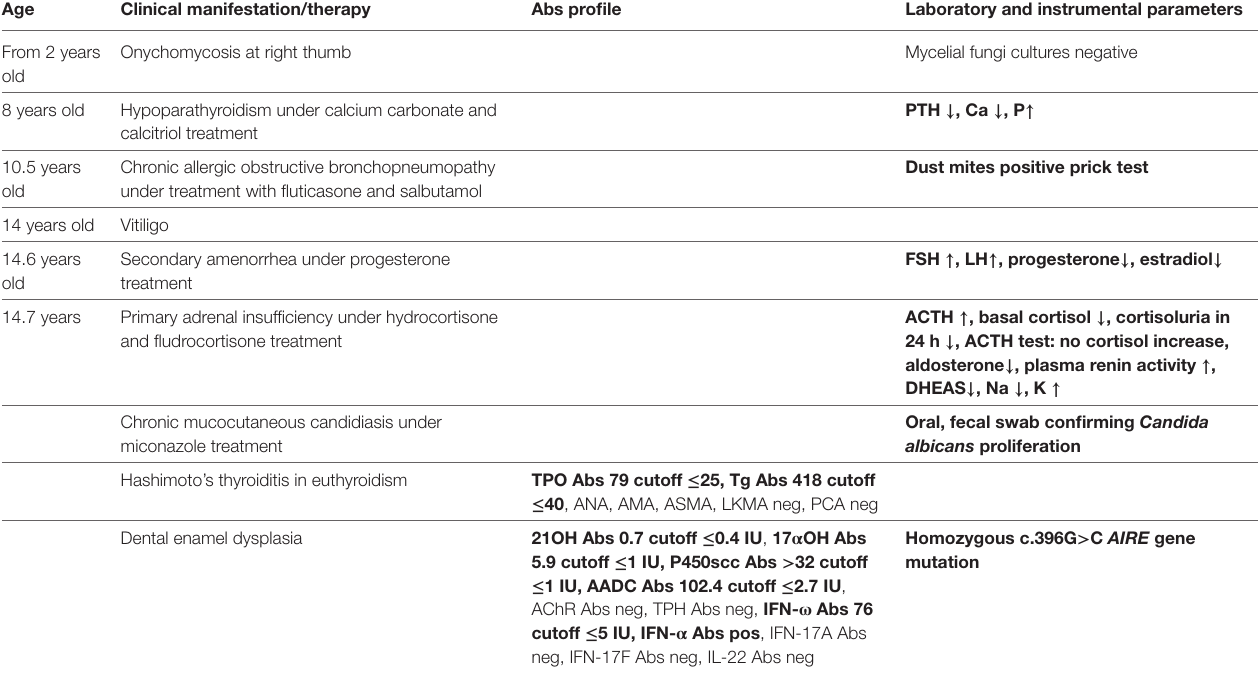
taBLe 1 | Data related to the present case report and published Pakistani APECED patients.